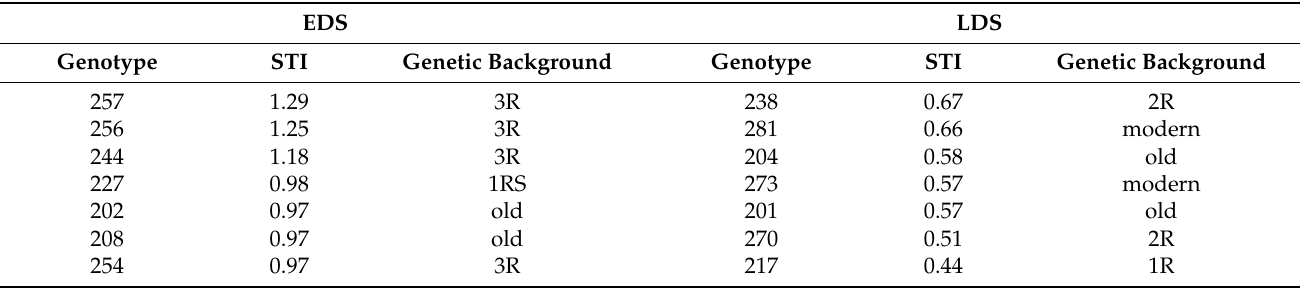
Table 1. Top 10% genotypes selected by stress-tolerance index (STI) of yield (grain weight per plant = GWPP) under early drought stress (EDS) and late drought stress (LDS).